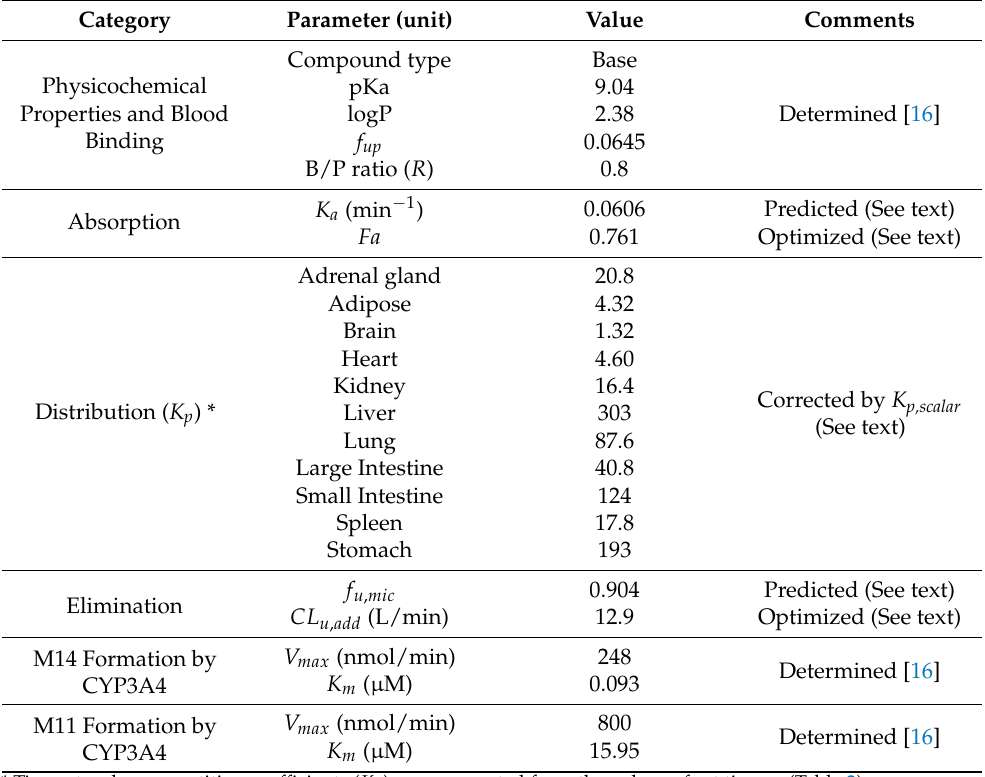
* Tissue-to-plasma partition coefficients ( K p ) were corrected from the values of rat tissues (Table